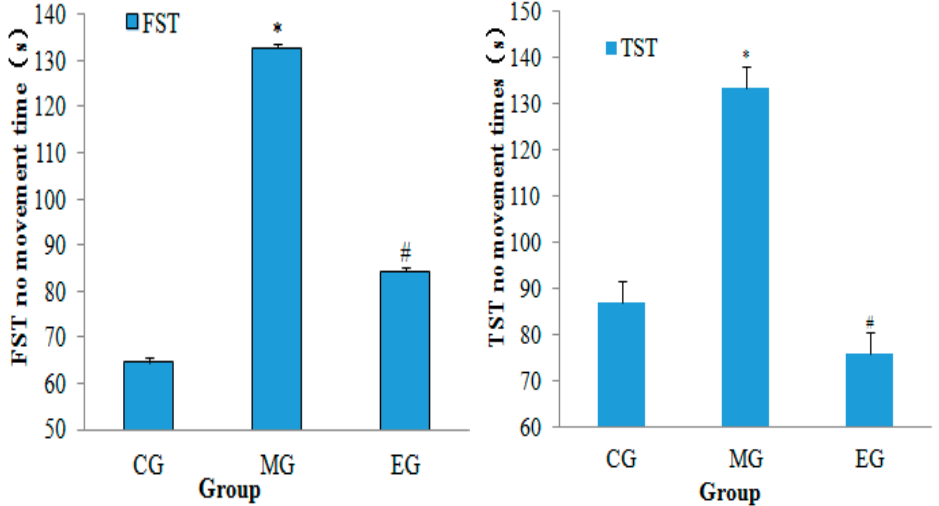
Figure 2. The changes of the total time of forced swimming and forced tail suspension. After exercise, each group consisted of 10 animals. The data were presented as the means ± SD. * p < 0.01, versus control group, # p < 0.01, versus model group (one-way ANOVA followed by the Kruskal–Wallis